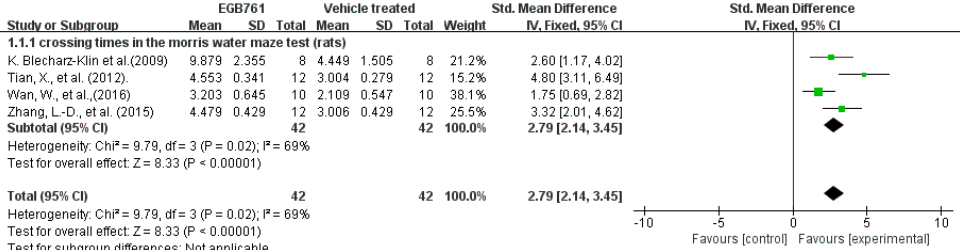
Figure 4. Forest plot for comparison: GBE treatment versus vehicle treatment. Outcome: numbers of times crossing the target quadrant in MWM. The square area represents the weight assigned to the study in the meta-analysis. The horizontal line represents the 95% confidence interval.